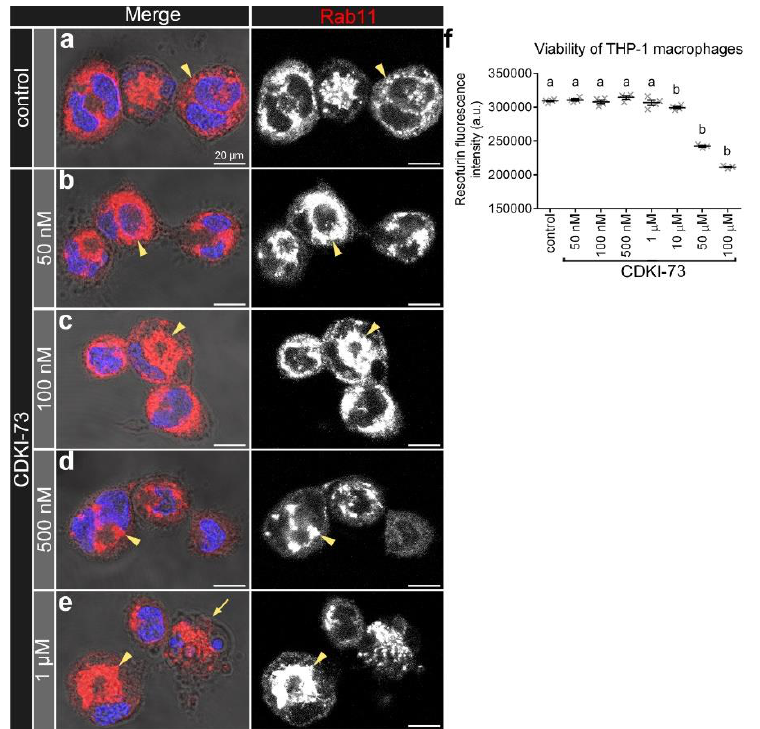
Figure 7. CDKI-73 causes accumulation of Rab11 endosomes in the perinuclear region of THP-1 macrophages. ( a – e ) Confocal micrographs showing Rab11 endosomes detected with anti-Rab11 antibody (red) in relation to the cell surface, detected by phase-contrast microscopy. The nucleus was depicted by staining with Hoechst 33,258 DNA stain (blue). Representative images were from control macrophages ( a ) and macrophages treated either with CDKI-73 at 50 nM CDKI-73 ( b ), 100 nM ( c ), 500 nM ( d ) or 1 μM ( e ) for four hours. Arrowheads depict Rab11 vesicles with altered distribution within the cell. Scale bars: 20 μm. ( f ) Histogram showing the levels of metabolic activity/redox state of macrophages after treatment with CDKI-73. One-way ANOVA and Dunnett’s multiple comparison test showed significant differences between the means in designated groups (depicted by different letters on the bars, p < 0.0001). Data are represented as mean ± SEM.